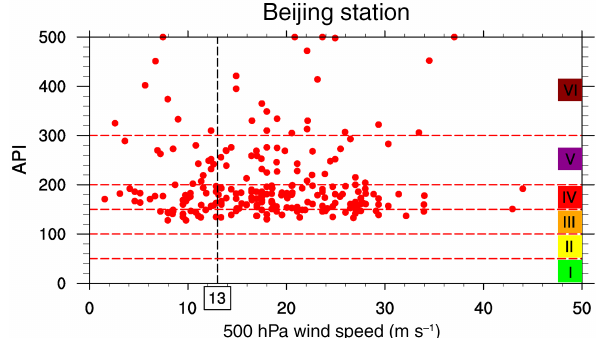
Figure 1. The relationship between the air pollution index (API) and 500hPa wind speeds on most polluted days (i.e., days when the API ranks in the 90th percentile or higher) in the boreal win- ter half-year (October–March) during 2000–2012 of Beijing station. Air pollution is classified into six levels (I–VI), which mean excel- lent, good, lightly polluted, moderately polluted, heavily polluted, and severely polluted conditions,